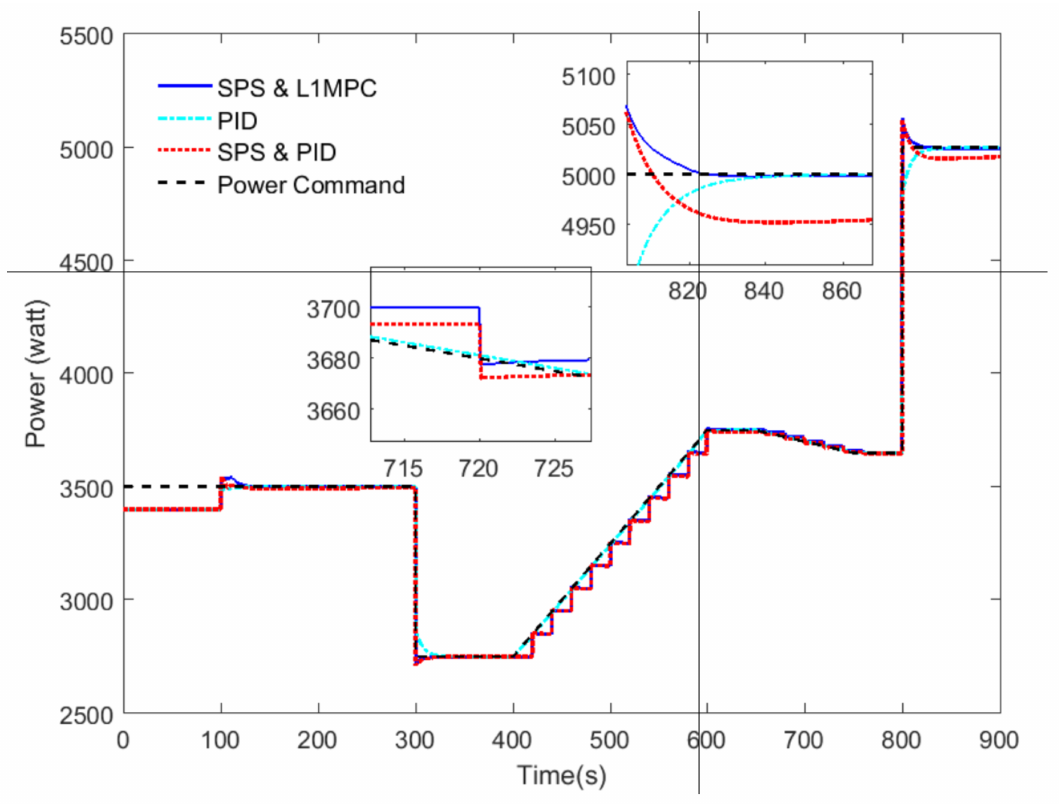
Figure 8. The power output of